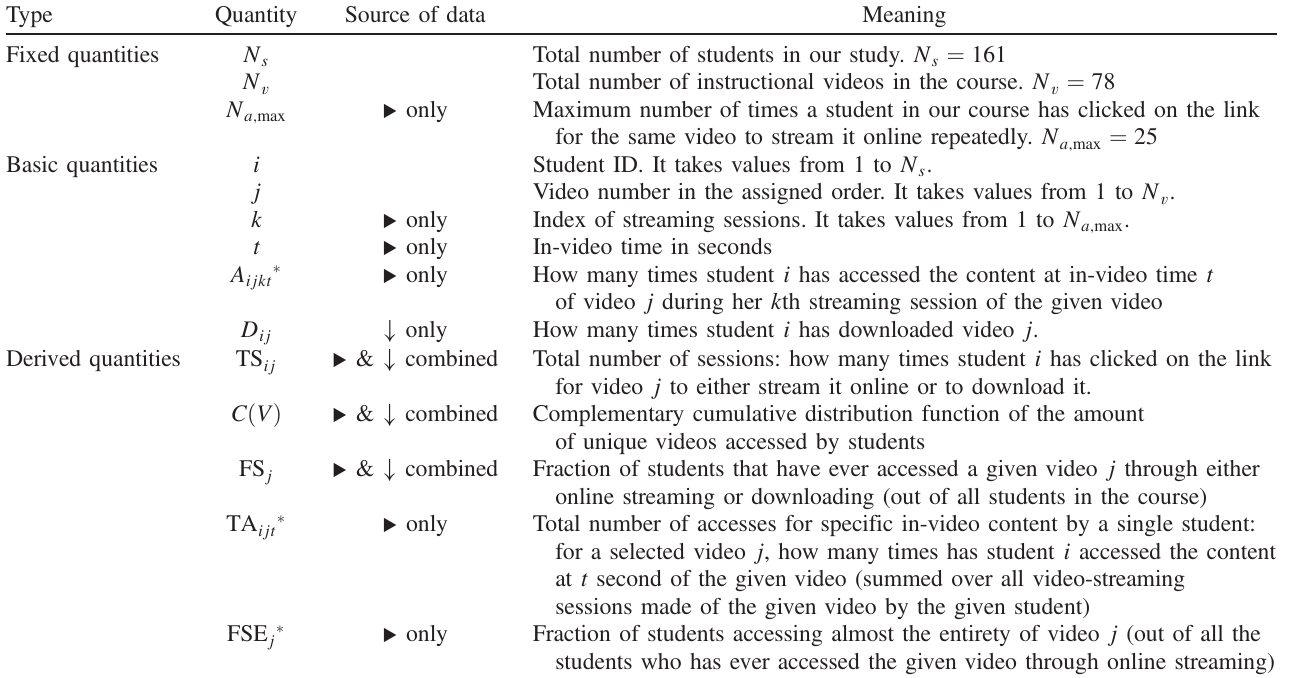
TABLE III. Short summary of the quantities used for describing students ’ video-accessing behaviors. In this table, quantities without an asterisk are obtained by examining whether or how many times students have started a video-accessing session (i.e., clicking on the link for a video) regardless of the amount of in-video content accessed within each session. On the other hand, quantities denoted with an asterisk are obtained by focusing on the exact in-video content that was accessed by students. In addition, the ▸ symbol indicates quantities that are constructed for cases of video accessing through online streaming, while the ↓ symbol indicates quantities that are constructed for cases of video accessing through